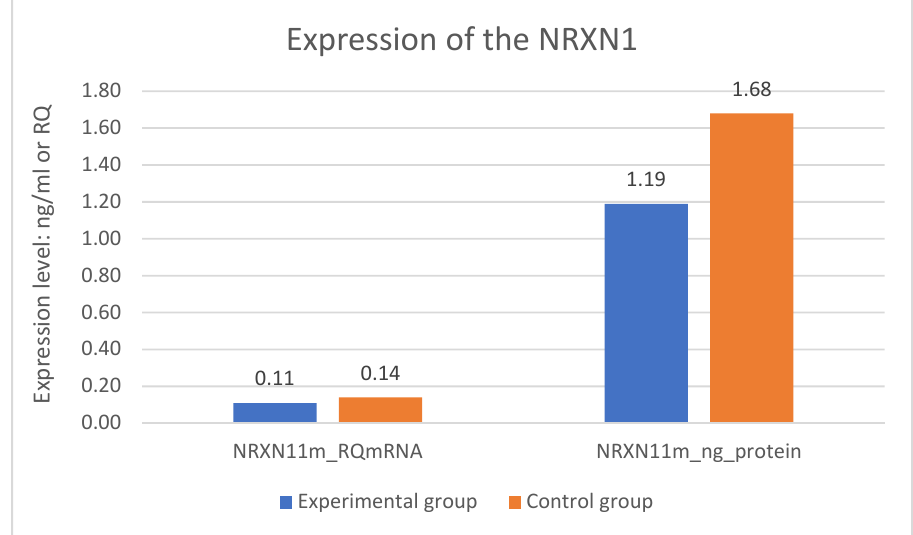
Figure 1. Expression of the NRXN1 gene in the examined groups.